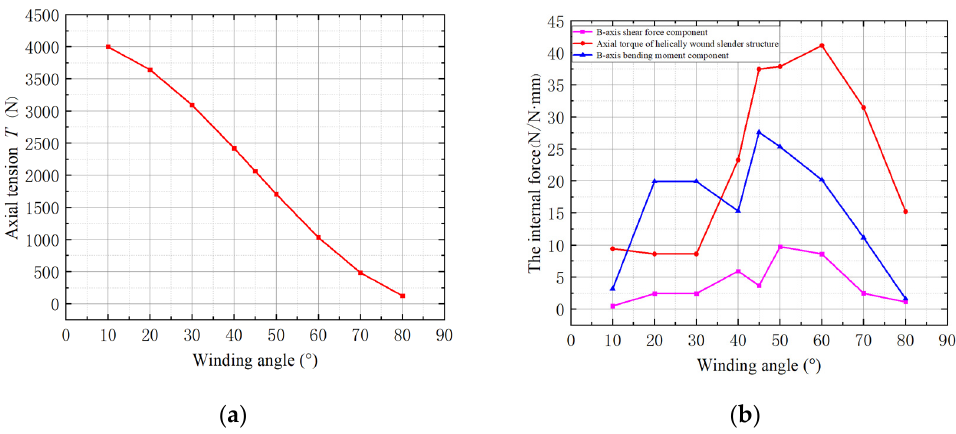
Figure 7. Numerical solutions of internal forces at different winding angles. ( a ) Axial tension, ( b ) other internal forces. ( b ) other internal